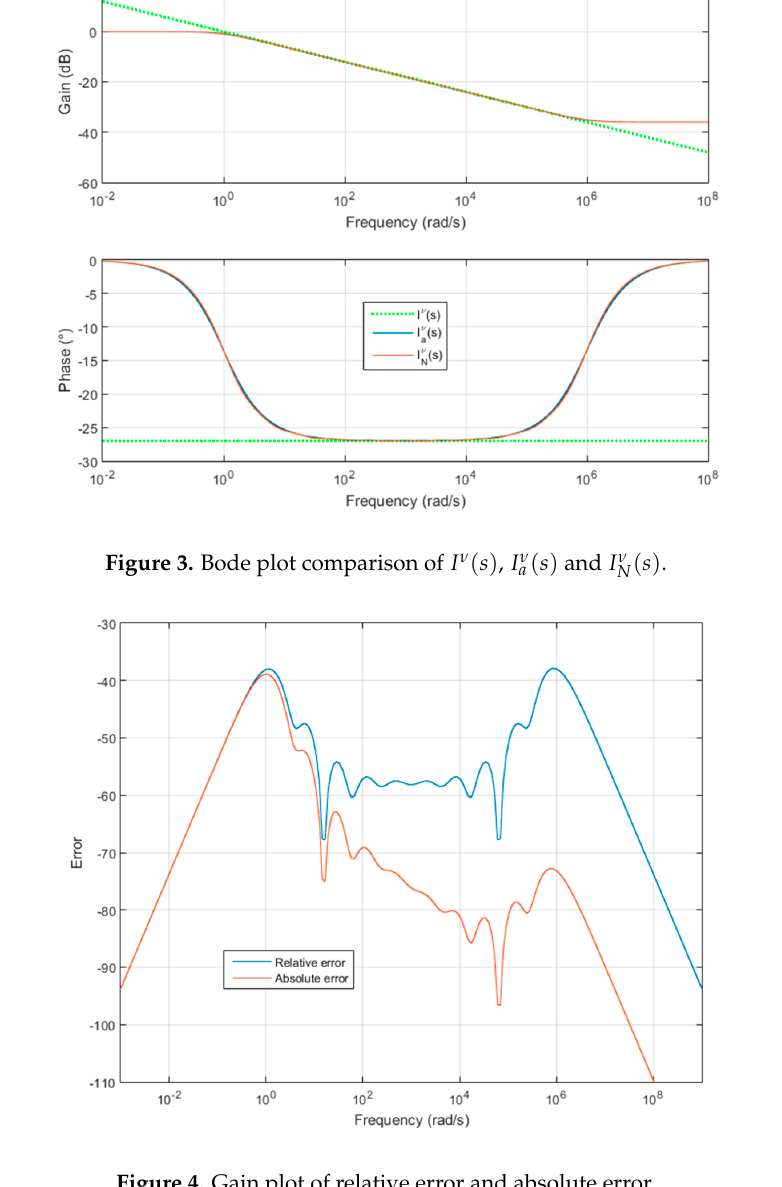
Figure 4. Gain plot of relative error and absolute error.